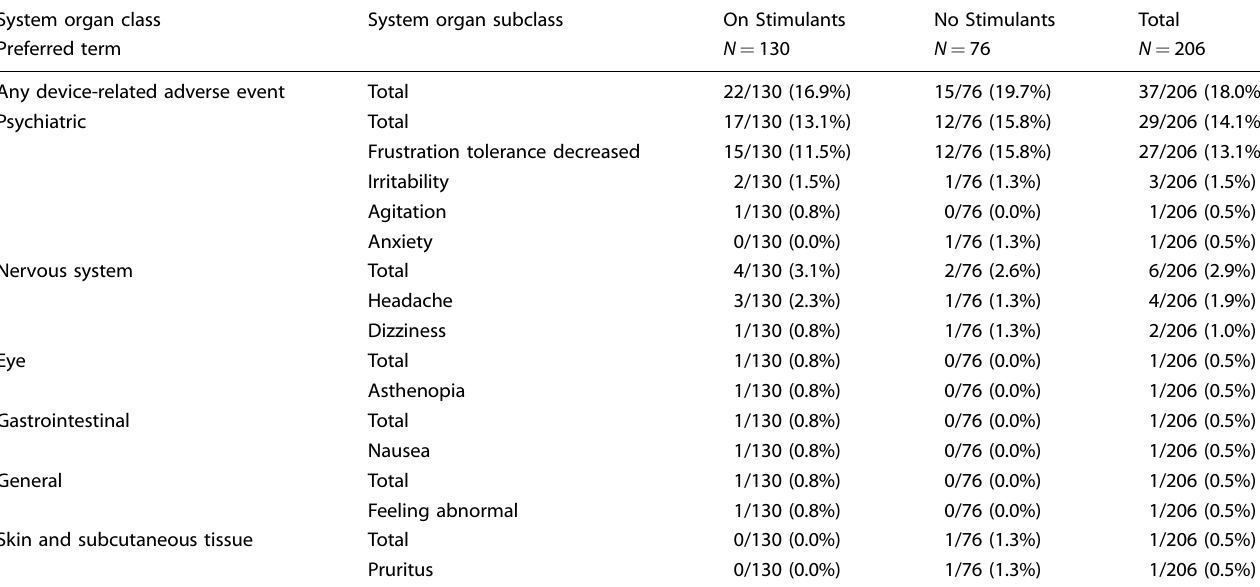
Table 5. Device-related adverse events by system organ class and preferred term (safety